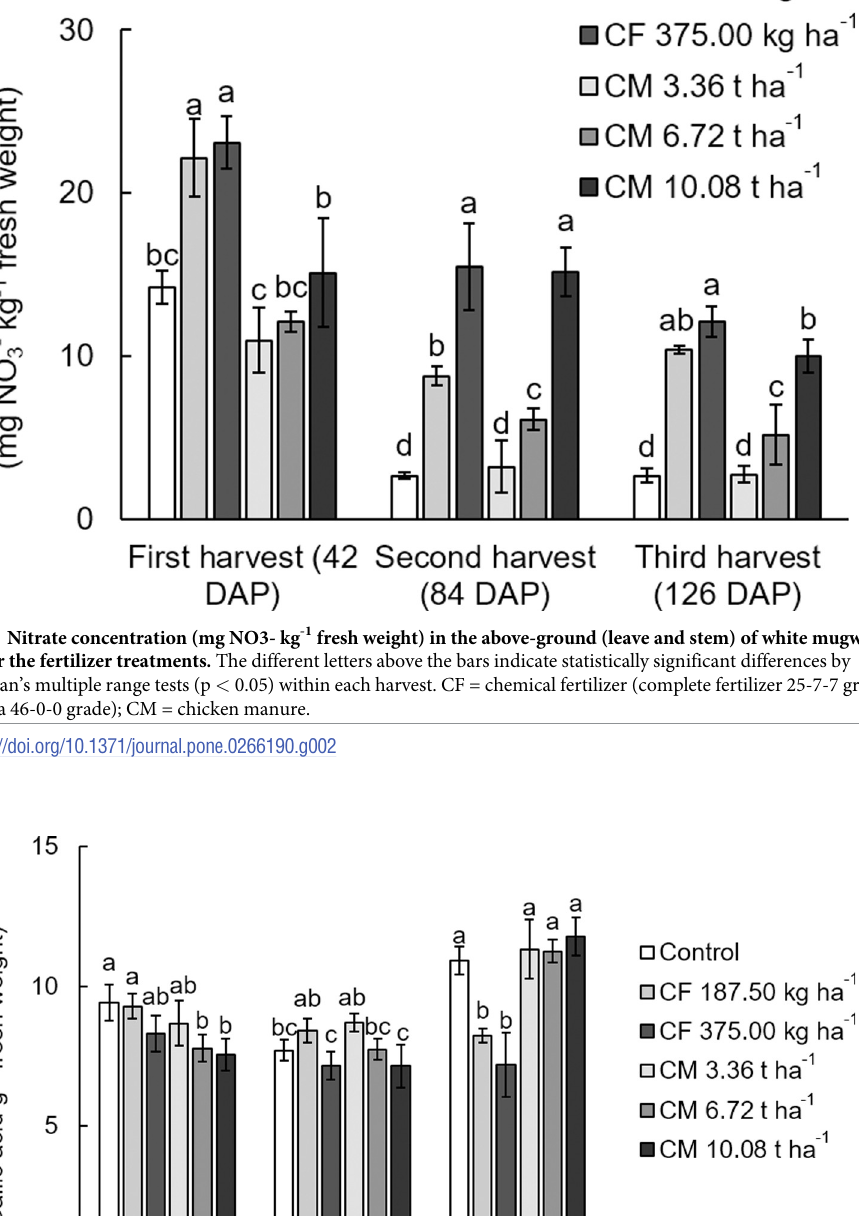
PLOS ONE | https://doi.org/10.1371/journal.pone.0266190 April 26,